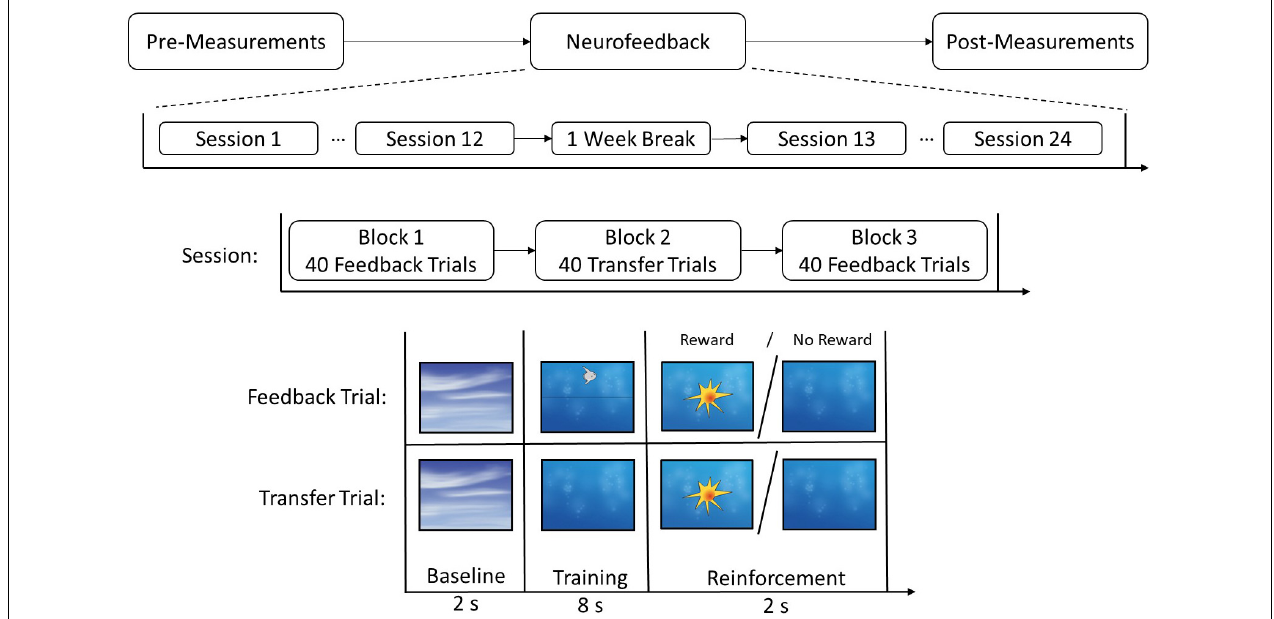
FIGURE 1 | Experimental timeline for the neurofeedback group. Participants received 24 sessions of neurofeedback, including a 1 week break between sessions 12 and 13. Every session entailed three blocks and each block consisted of either 40 Feedback or 40 Transfer trials. The trials included a baseline, a training, and a reinforcement phase. In the reinforcement phase, participants received positive visual feedback (reward) if the trial was successful and no feedback if the trial was not successful. Copyright Neurofeedback Screens © neuroConn GmbH/neurocare group AG.